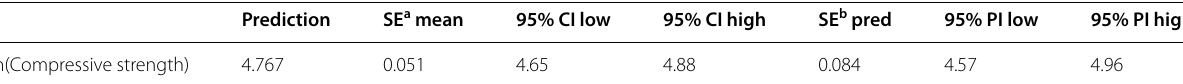
Table 8 Statistical analysis of the response